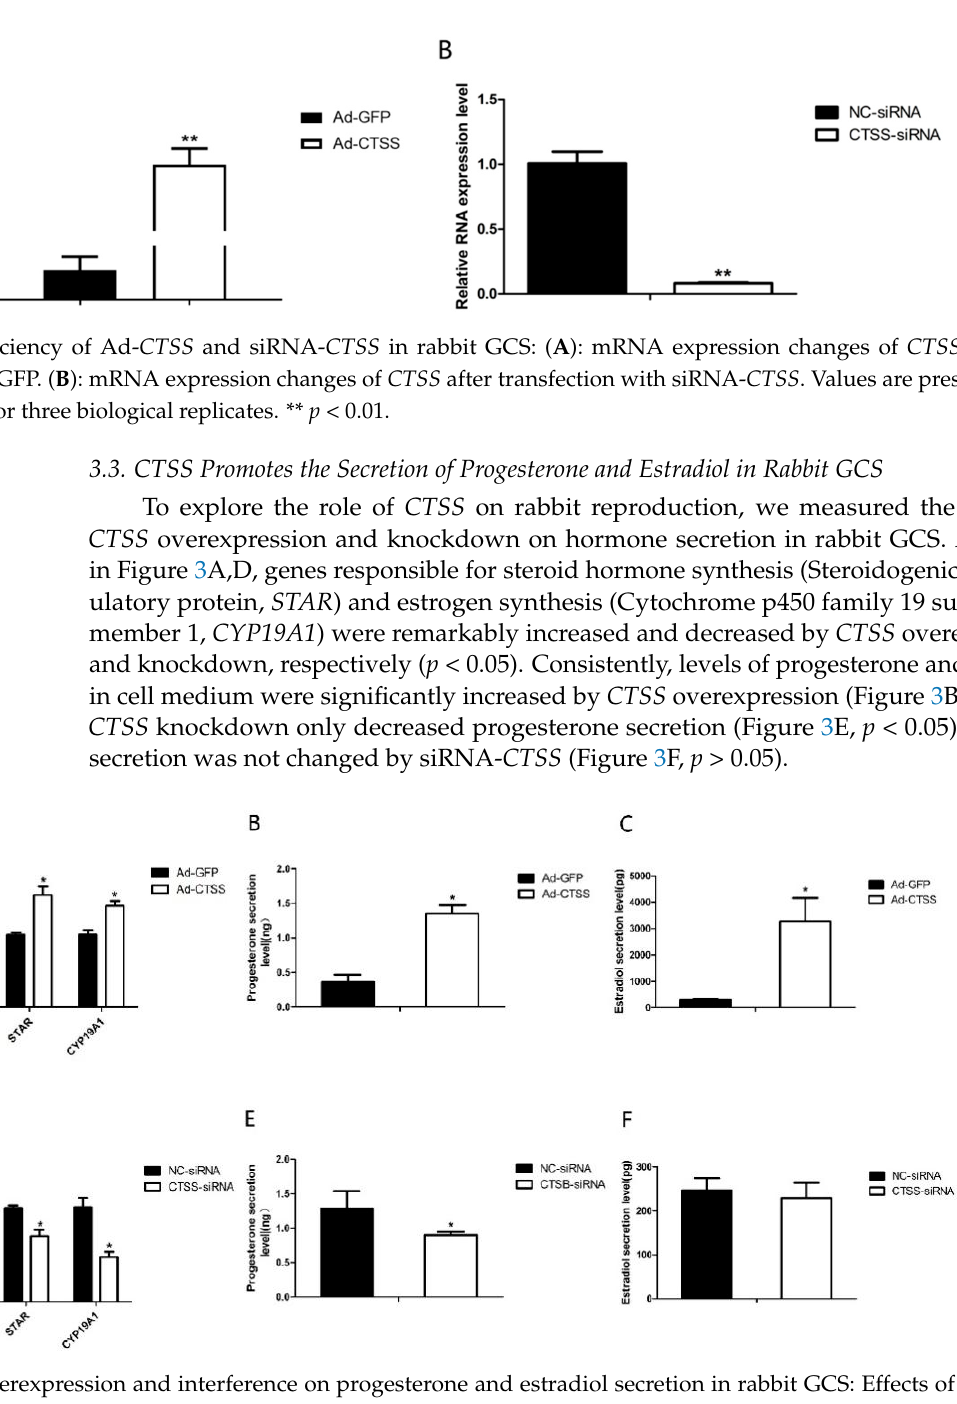
Figure 3. CTSS overexpression and interference on progesterone and estradiol secretion in rabbit GCS: Effects of CTSS overexpression and knockdown on ( A , D ) mRNA expression changes of genes related to progesterone and estradiol secretion; ( B , E ) progesterone secretion and ( C , F ) estradiol secretion. Values are presented as means ± SEM for 3 biological replicates. * p < 0.05.